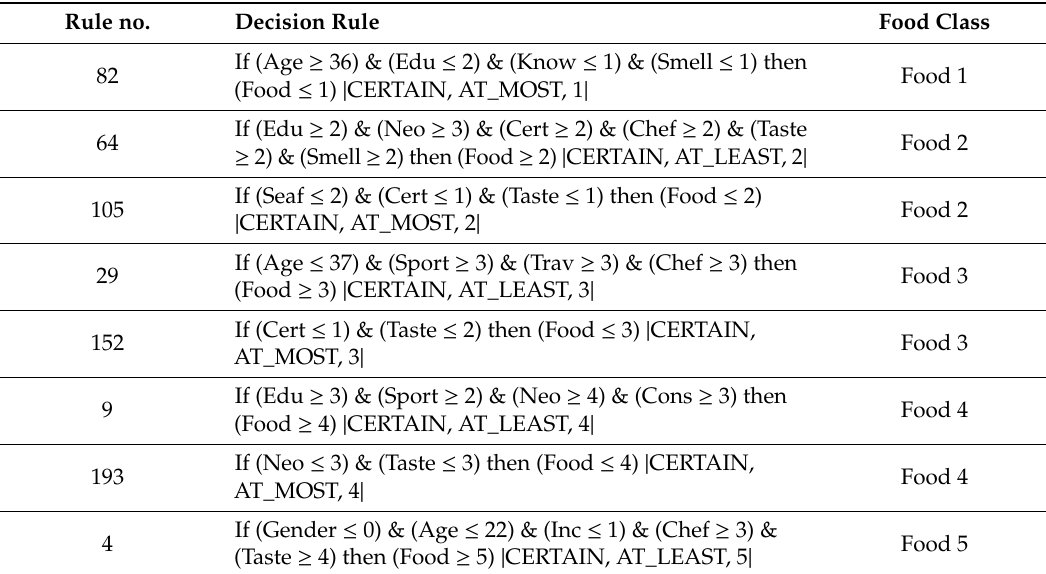
Table 5. Examples of certain decision rules for each food class.